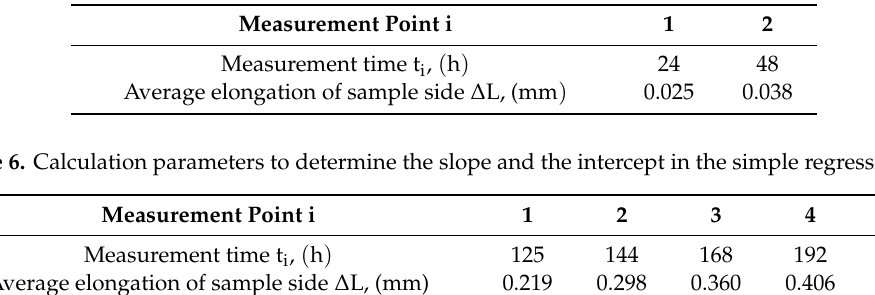
Commented [TK7]: The figure was changed.